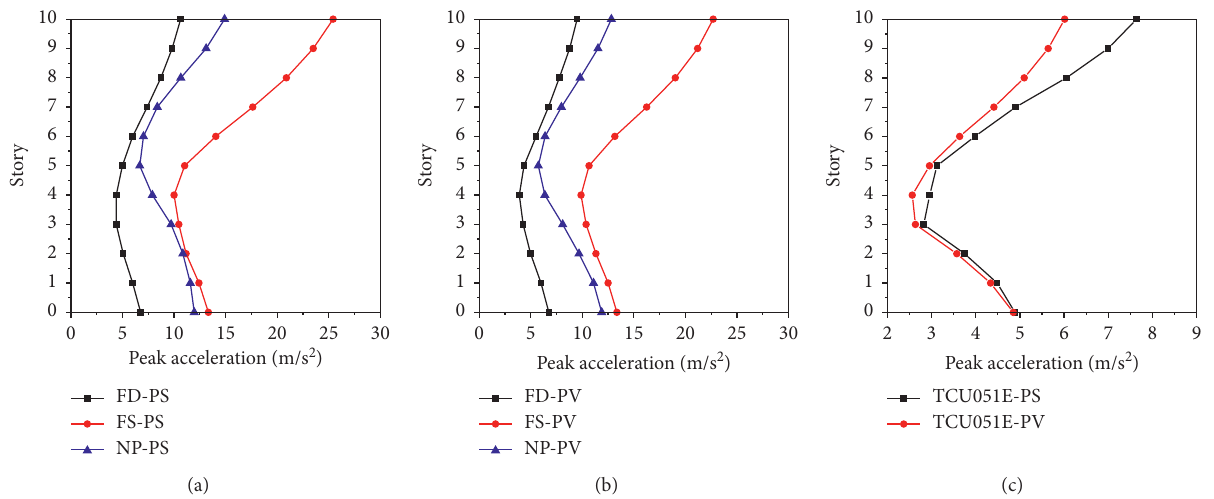
Figure 12: The average peak acceleration of the structure under seismic excitations with velocity pulse: (a) the SSI system without viscous dampers; (b) the SSI system with viscous dampers; (c) the ground motion of TCU051E.